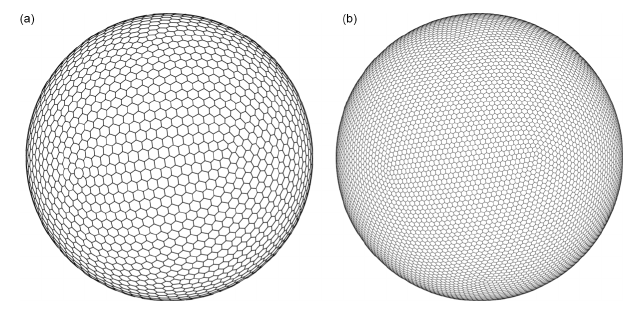
Figure 5. Two global SCVT meshes of the sphere surface with dif- ferent grid resolutions: 480km (a) and 240km (b) .